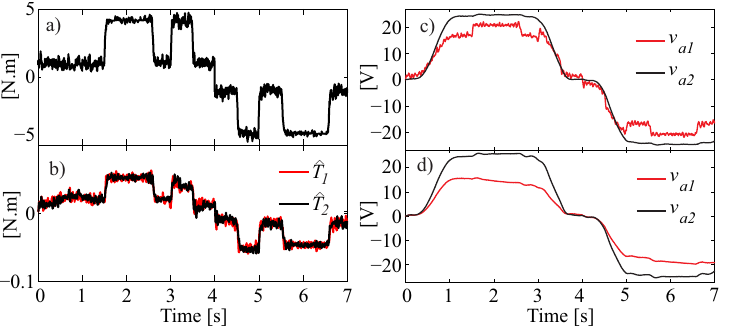
Figure 9. ( a ) Load torque applied on the common stiff shaft, ( b ) internal developed torque on each brushed DC motor, input voltage response ( c ) with and ( d ) without digital torque